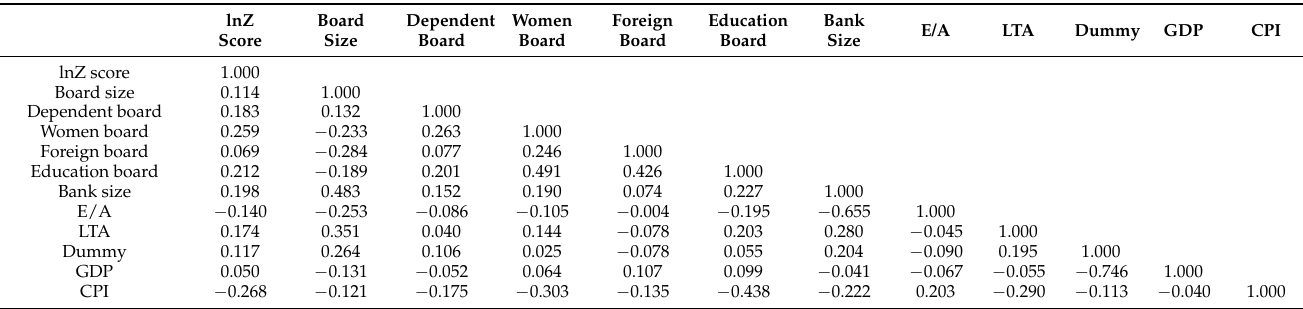
Table 3. Pearson correlation